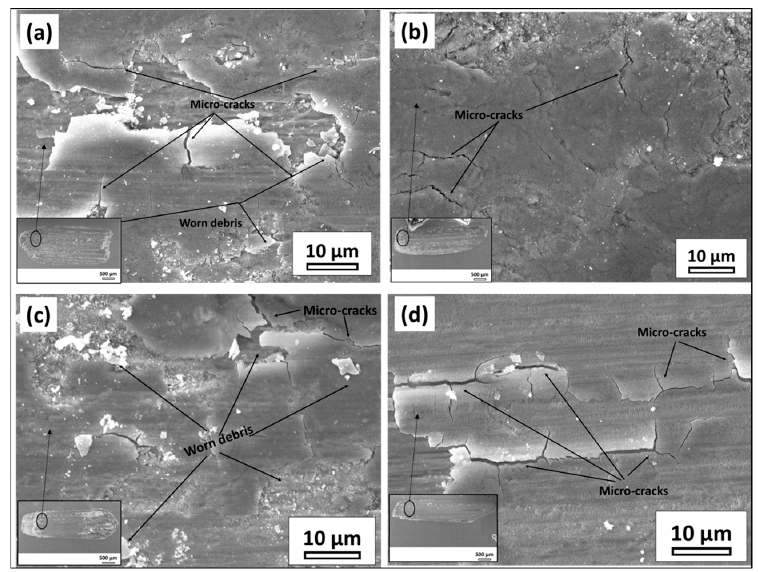
Figure 11. Wear test of EN25 steel for different sample conditions ( a ) Base metal, ( b ) S1000V60I35 OD 2 mm, ( c ) S1000V60I35 OD 0.5 mm, and ( d ) S1000V60I35 WO, all for load 30 N track length 2 mm and frequency 10 Hz.